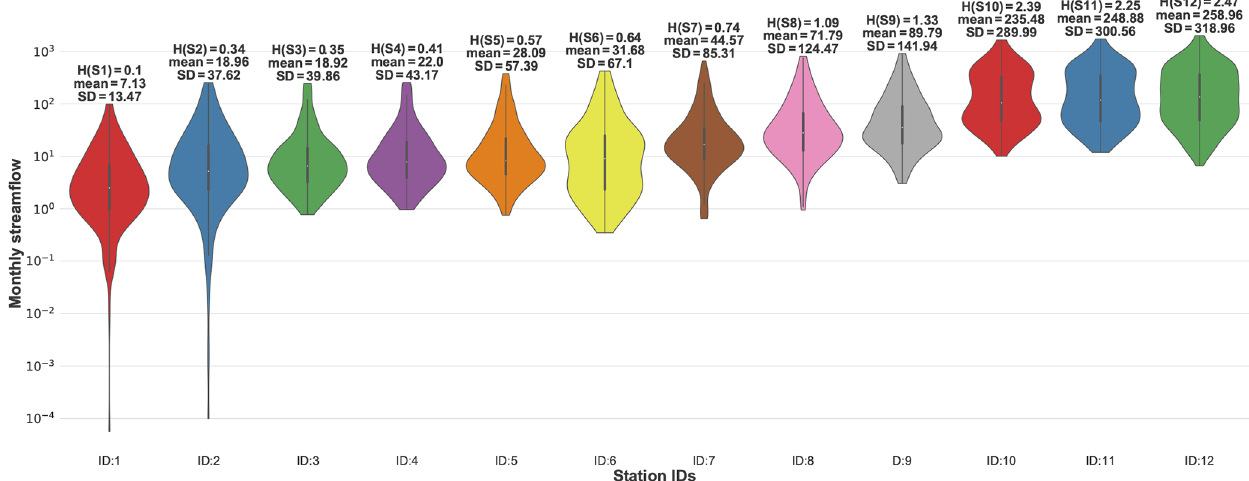
Figure 4. Brazos River streamflow ( m 3 s − 1 ) statistics and resulting entropy values (bits). The stations’ IDs are organized from upstream to downstream gauges in the watershed. Entropy values are calculated by floor function and parameter a = 150m 3 s − 1